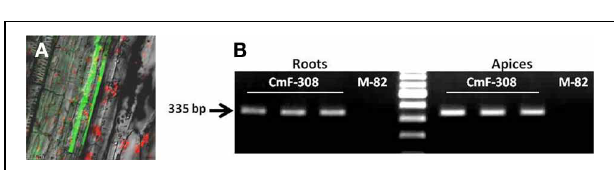
FIGURE 4 | (A) Activity of AtSUC2 promoter in transgenic tomato plants. GFP is visualized the vasculature (companion cells) of tomato stem. (B) Presence of CmF-308 transcript in shoot apices and roots of three independent transgenic tomato plants expressing the gene under the AtSUC2 promoter. The commercial variety M-82 served as a control for the RT-PCR